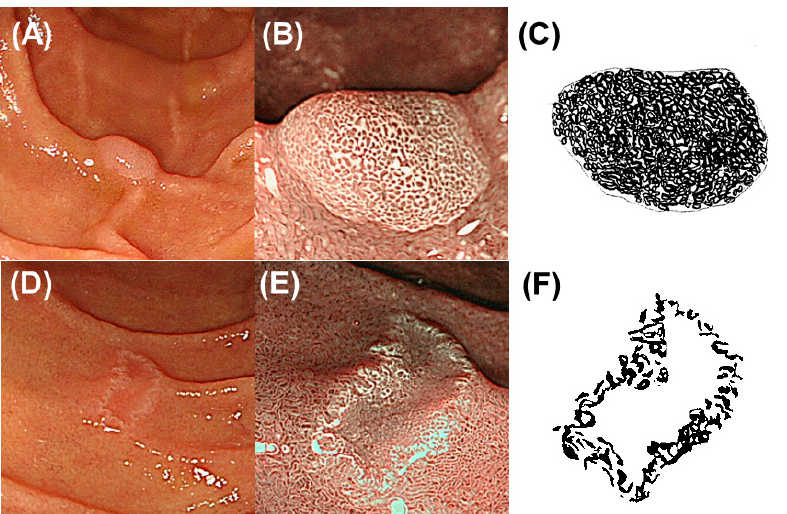
Figure 1. Representative images of entire-type and non-entire-type milk-white mucosa (MWM). ( A , B ) Representative endoscopic images of a superficial non-ampullary duodenal epithelial tumor (SNADET) with entire-type MWM. ( A ) White-light endoscopic image showing a small, elevated lesion. ( B ) Narrow band imaging (NBI) magnification endoscopic image showing MWM throughout the elevated lesion corresponding to entire-type MWM. ( C ) Schematic diagram of entire-type MWM. The black area shows the endoscopic MWM-positive area throughout the lesion. The endoscopic MWM-positive rate was 95%. ( D , E ) Representative endoscopic images of a SNADET with non-entire type MWM. ( D ) White-light endoscopic image showing a small, depressed lesion. ( E ) NBI magnification endoscopic image showing MWM only along or near the margin corresponding to non-entire type MWM. ( F ) Schematic diagram of non-entire type MWM. The endoscopic MWM-positive rate was 40%.